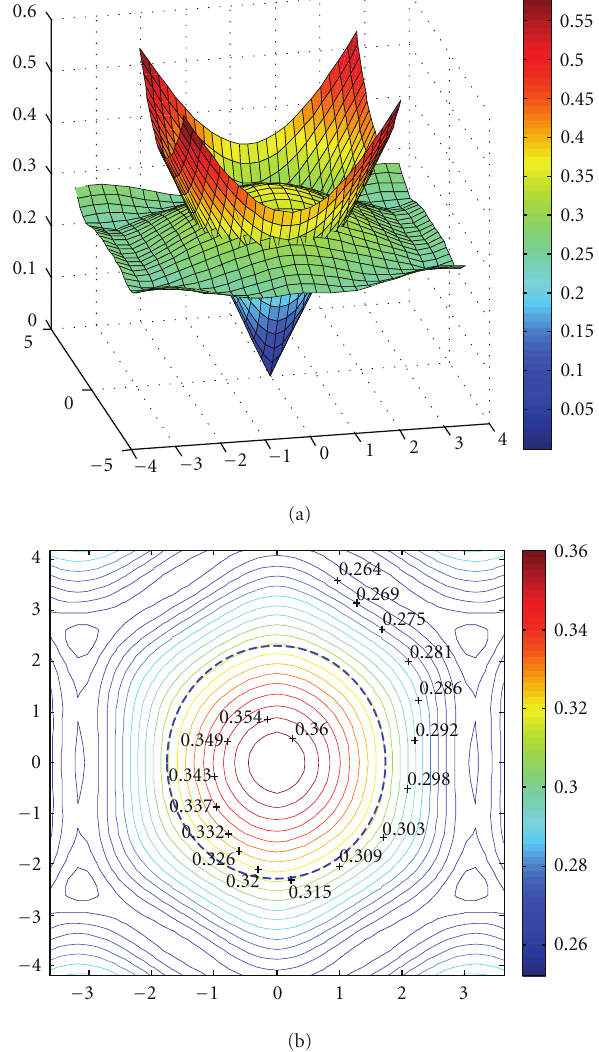
Figure 6: Band structure and EFCs of the second band of the 2D PhC of hexagonal lattice for TM polarization. Values of frequency are in units of 2 πc /a . (a) Surfaces of the second band and light cone. (b) EFCs of the 2nd band. The blue dotted circle is the line of intersection of the second band surface and the light cone.